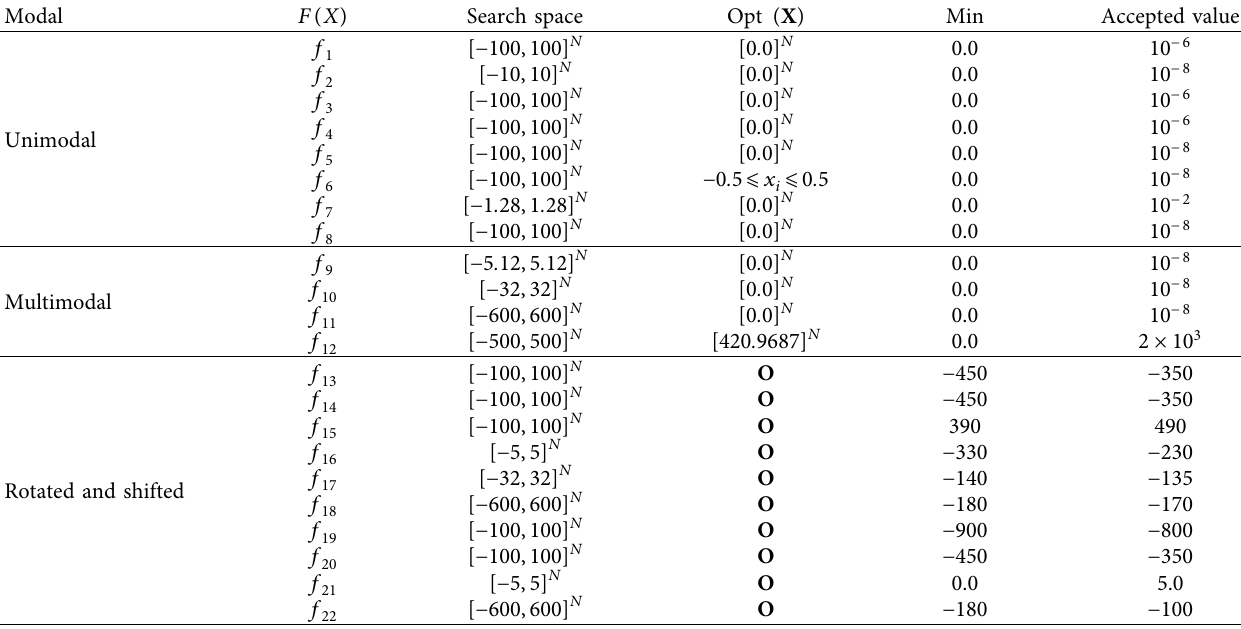
Table 2: Detailed information of test functions modal.